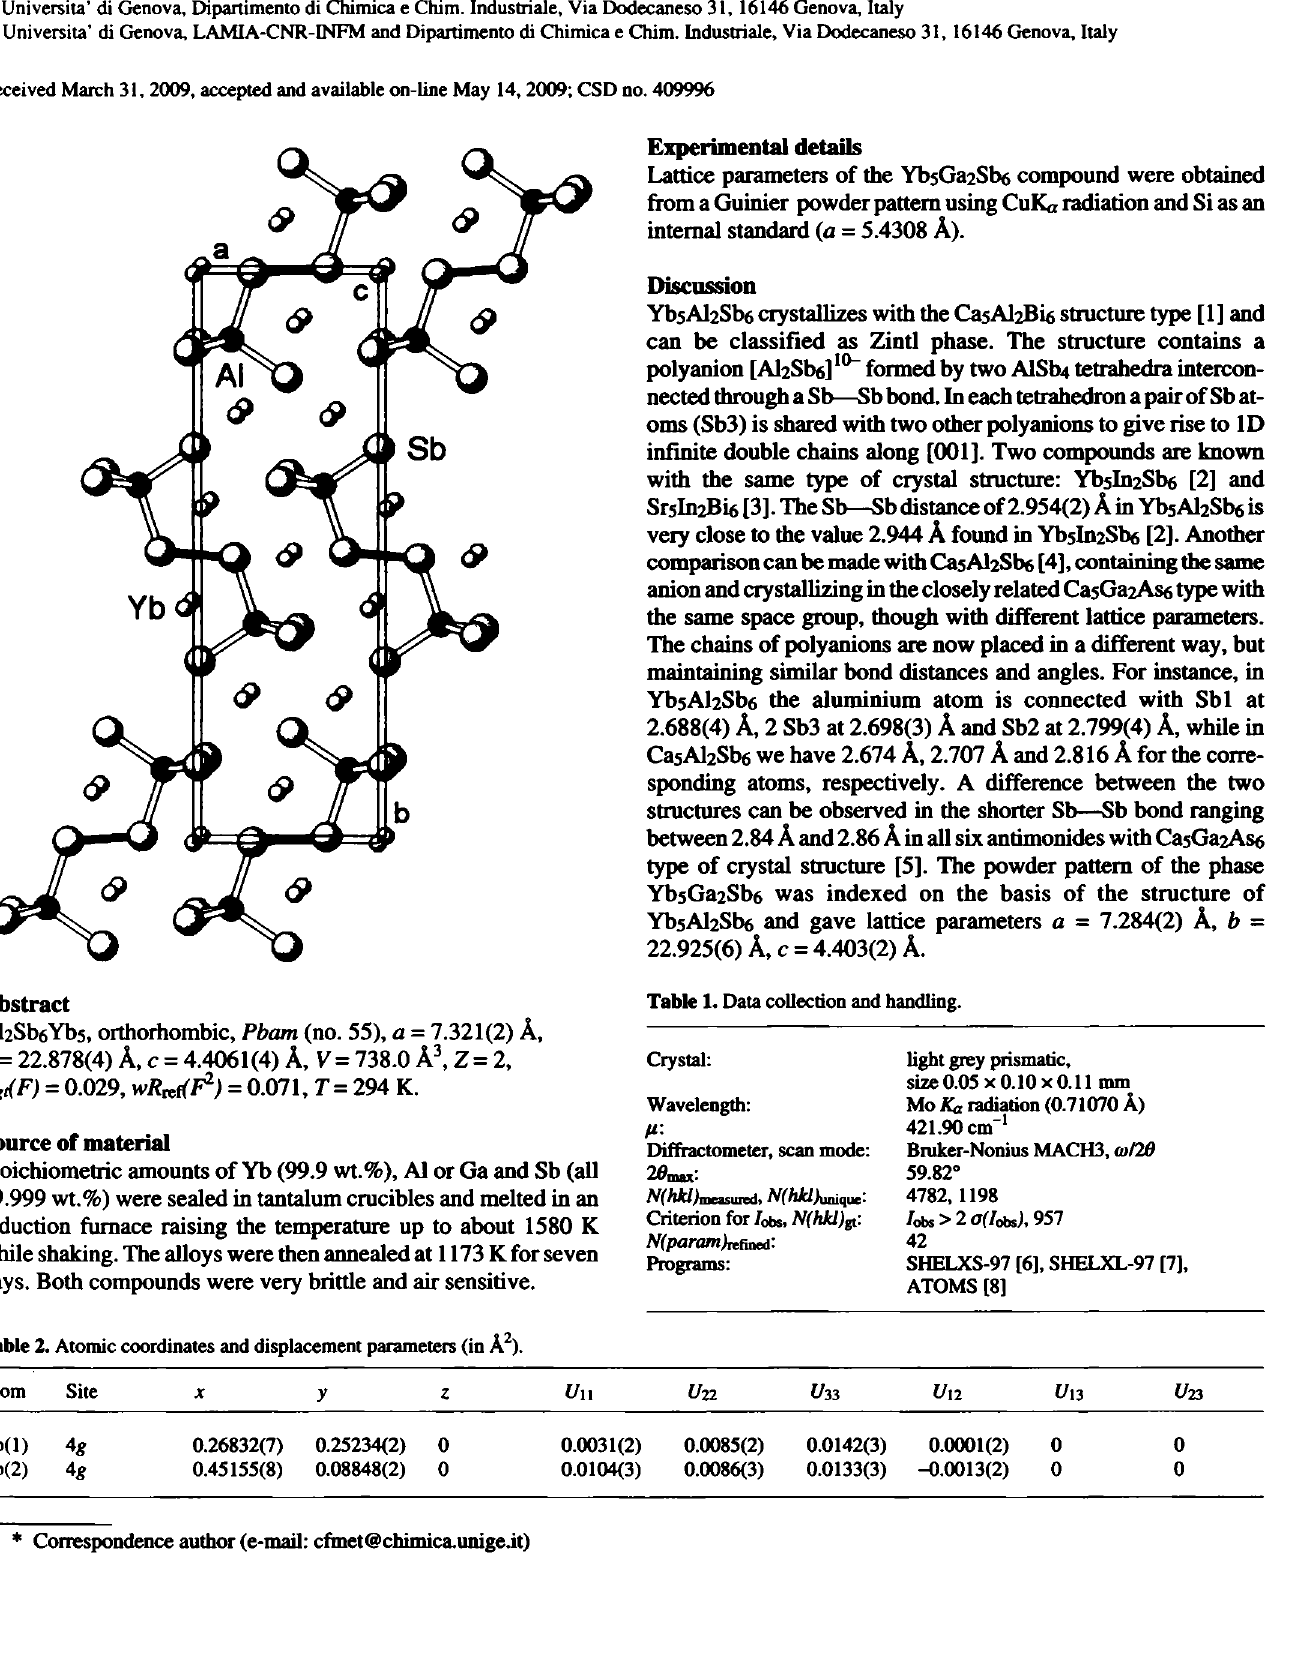
Table 2. Atomic coordinates and displacement parameters (in Â 2 ).